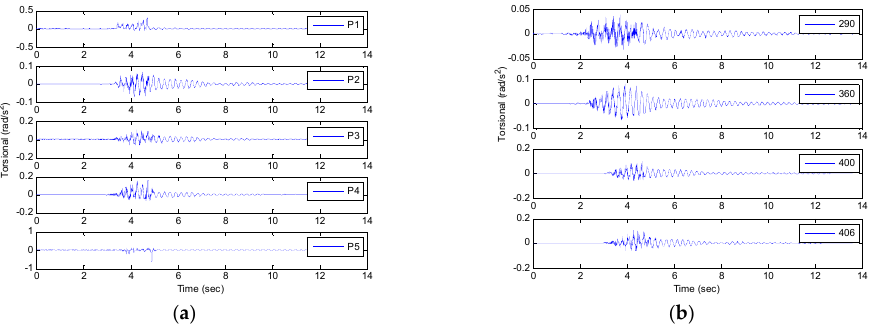
Figure 6. Torsional measurements for the bridge girder. ( a )the torsional of the monitoring points at 406 km/h passage; ( b )mid span point torsional values.